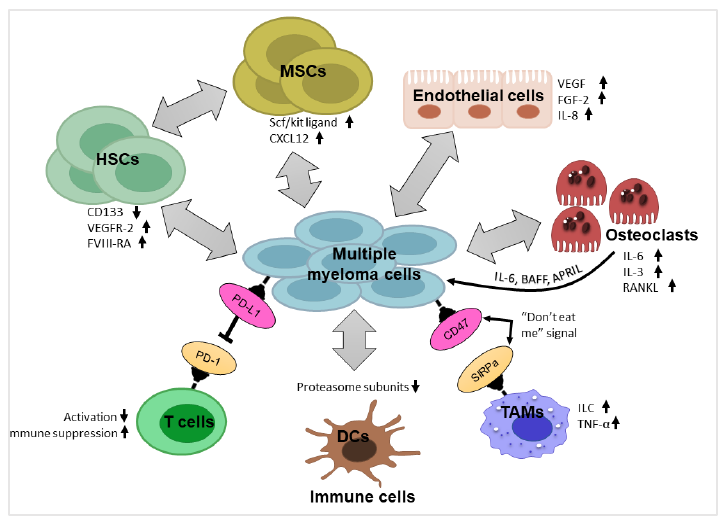
Figure 1. Impact of some critical components of tumor microenvironment on MM